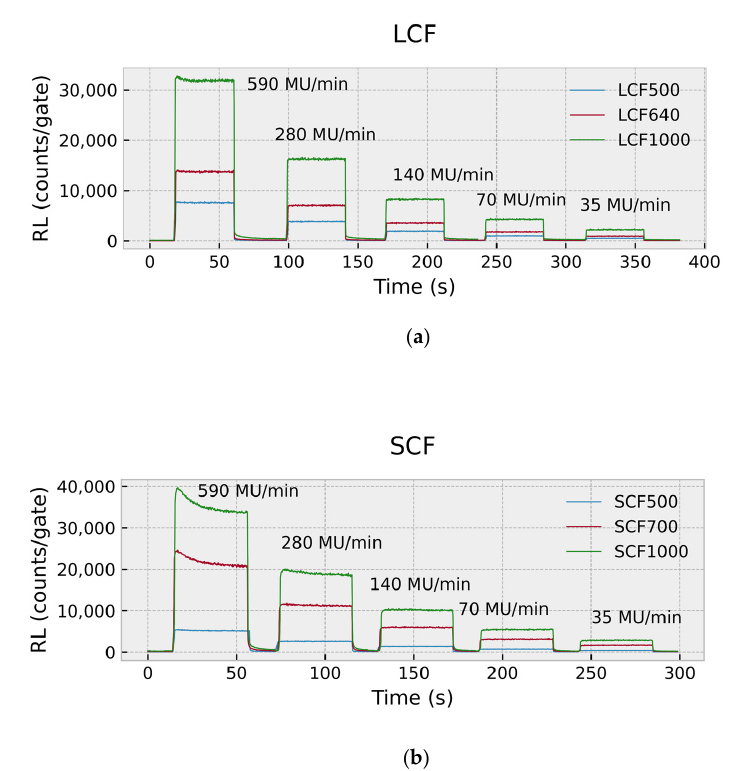
Figure 5. RL response (gate time of 100 μ s) of the ( a ) LCF and ( b ) SCF samples exposed at a fixed duration of 40 s.